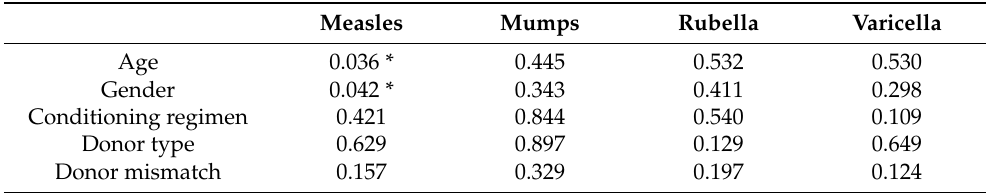
Table 3. Influence of age, gender, conditioning regimen, donor type and donor mismatch on antibody titers at T + 5 by univariate logistic regression. Asterisks mark significant